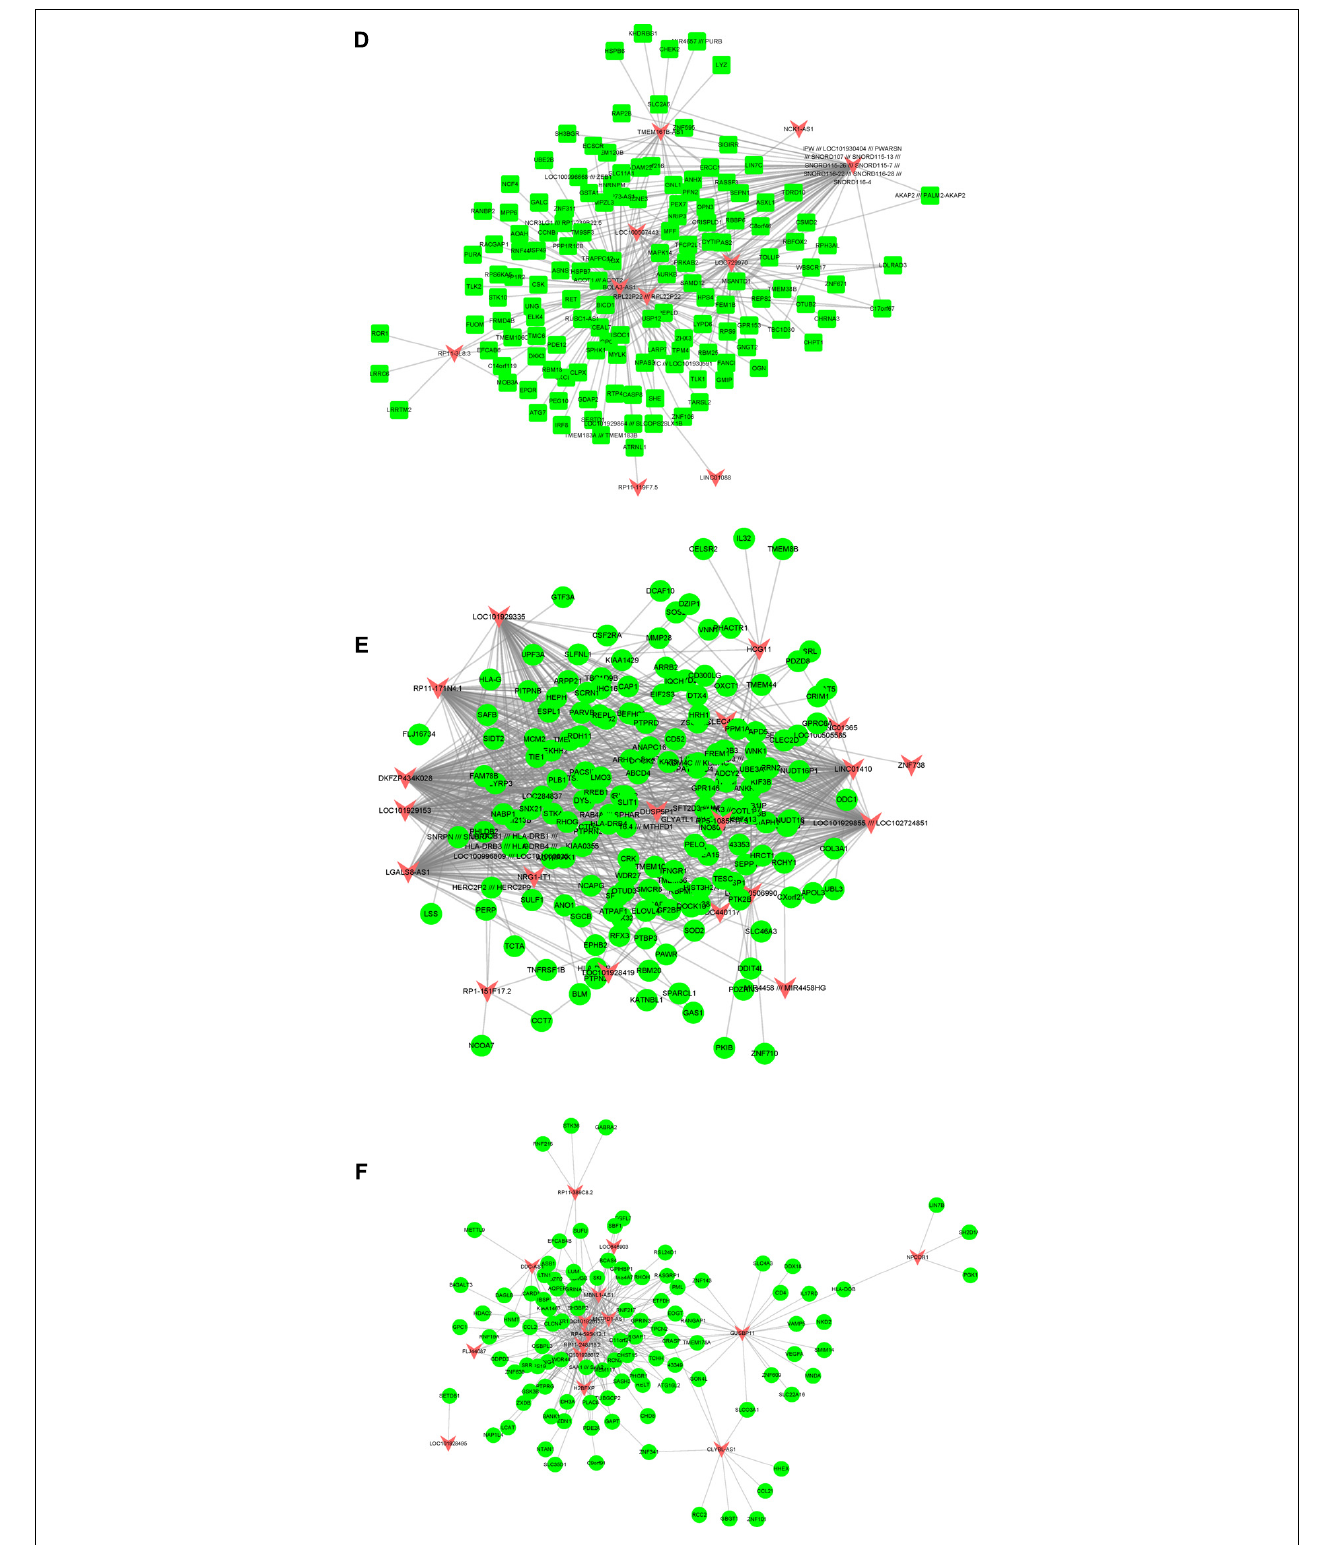
FIGURE 3 | Result of atherosclerosis related lncRNA-mRNA co-expression networks. Construction of module 7–12 lncRNA-mRNA co-expression networks based on WCGNA analysis. (A–F) The co-expression networks of module 1 (A) , module 2 (B) , module 3 (C) , module 4 (D) , module 5 (E) , and module 6 (F) .